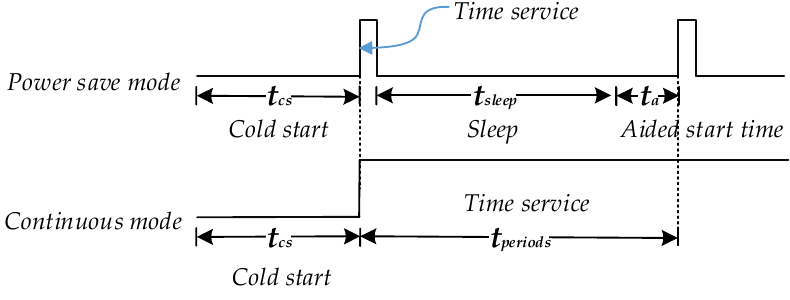
Figure 8. The working state of GPS in power save mode and continuous working mode.